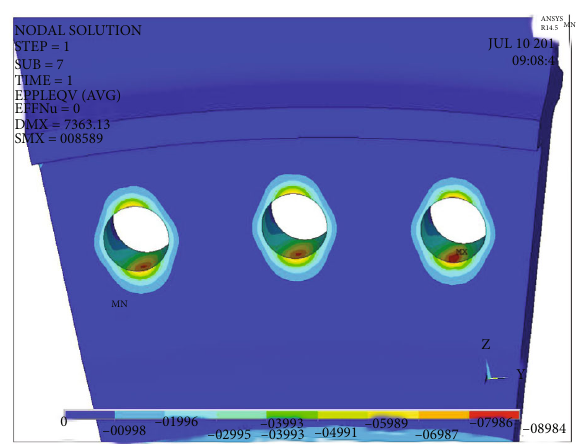
Figure 11: Web EPS distribution.